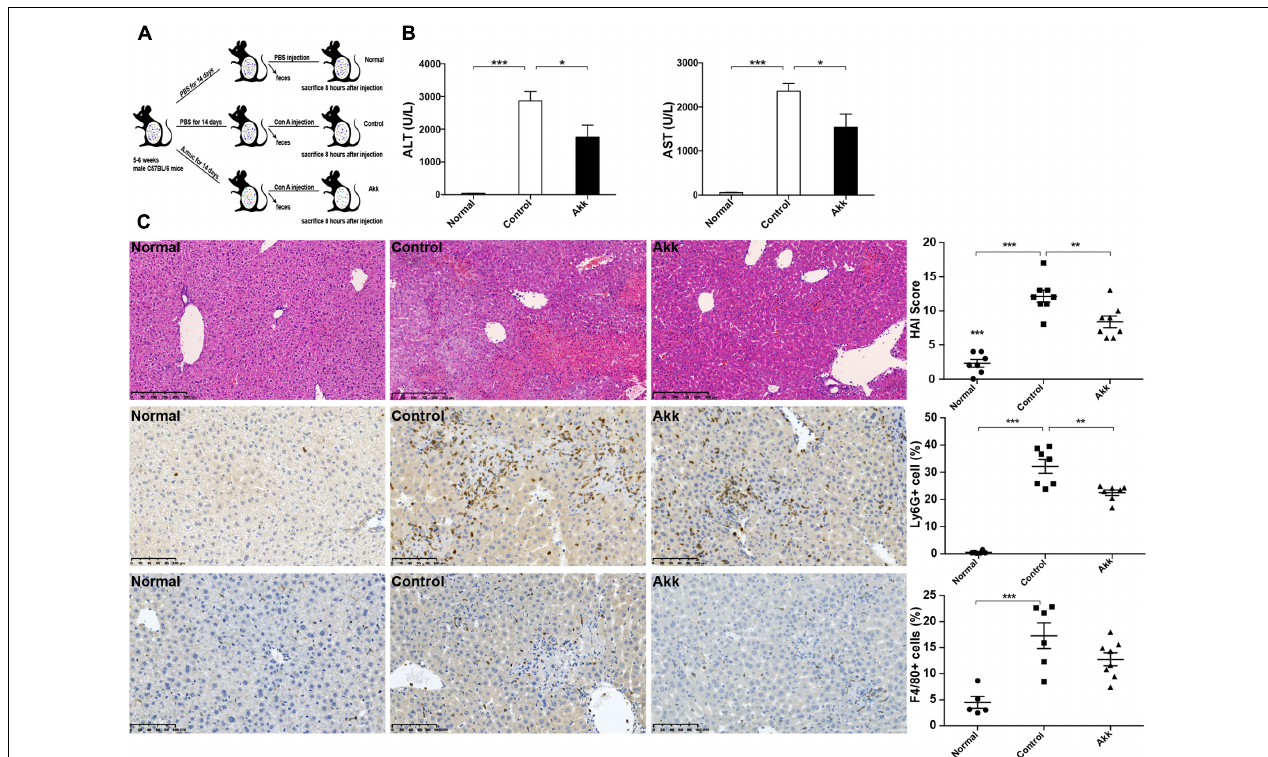
FIGURE 1 | Akkermansia muciniphila administration inhibited Con A-induced acute liver injury. (A) Design of the animal experiment. Mice were randomly distributed to three groups (Normal, n = 8; Control, n = 7; Akk, n = 7). Mice were pretreated with PBS or A. muciniphila continuously for 14 days by gavage. On day 15, feces from each mouse were collected, and Con A was injected. Eight hours later, mice were sacrificed. (B) Serum levels of ALT and AST ( n = 7–8 per group). (C) Representative liver histology. Upper panel: Left, H&E staining, scale bar, 250 µ m; Right, modified HAI scores of liver histopathology. Middle panel: Left, staining of neutrophils (Ly6G + ), scale bar, 100 µ m; Right, percentage of Ly6G + cells. Lower panel: Left, staining of macrophages (F4/80 + ), scale bar, 100 µ m; Right, percentage of F4/80 + cells. Data are shown as the mean ± SEM. ∗ P < 0.05; ∗∗ P < 0.01; ∗∗∗ P < 0.001 by post hoc ANOVA one-way statistical